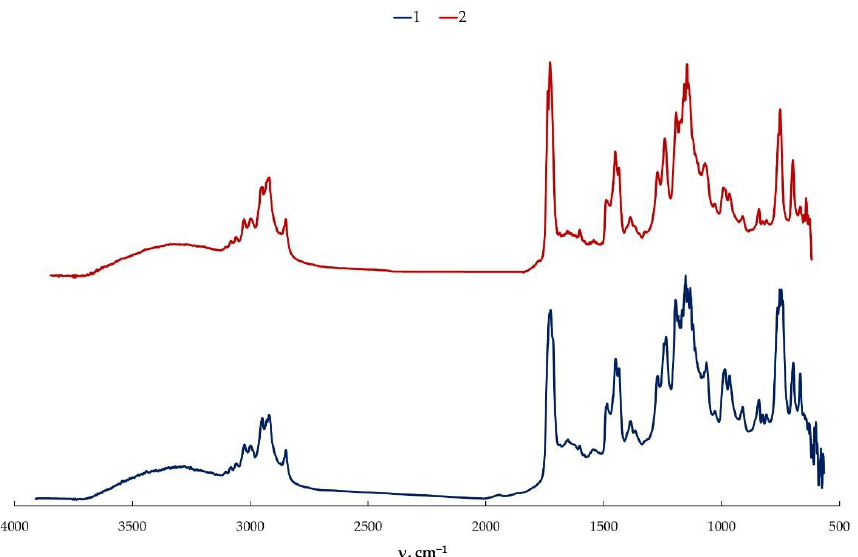
Figure 1. IR spectra of ( 1 ) homopolymer formed during graft-polymerization MMA onto gelatin in the presence of AIBN, TBB, and 2,5-DTBQ; ( 2 ) PMMA synthesized by radical polymerization initiated AIBN. Table 1. The yield of the homopolymer and the percentage of grafted PMMA in the Gel-PMMA